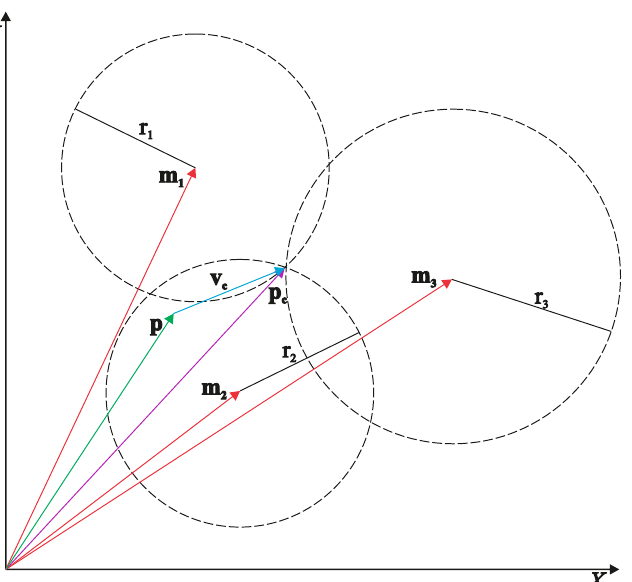
Figure 6. Determination scheme of position correction vector when three markers are detected.